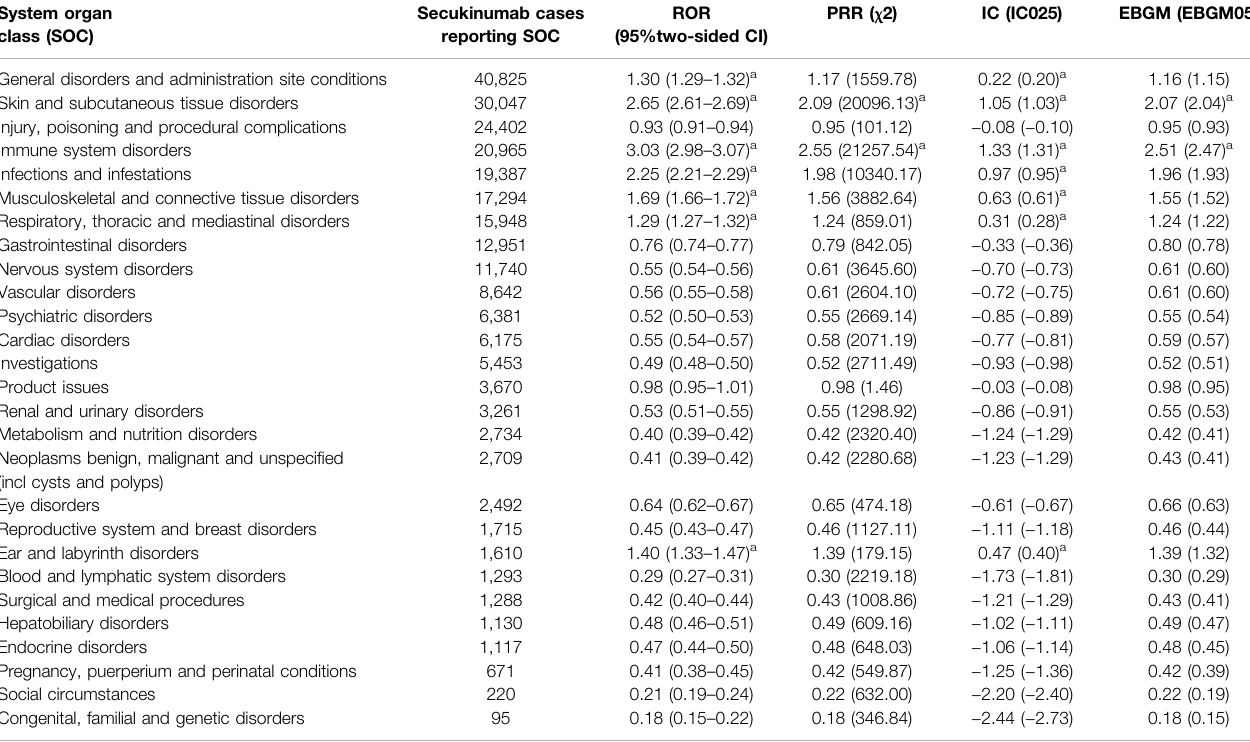
Figure 2 illustrated, most of the onsets of secukinumab occurred within the fi rst 1 ( n = 9845, 42.43%), 2 ( n = 2069, 8.92%), 3 ( n = 1619, 6.98%) and 4 months ( n = 1221, 5.26%) after initiation of secukinumab. About 15.13% ( n = 3510) of AEs